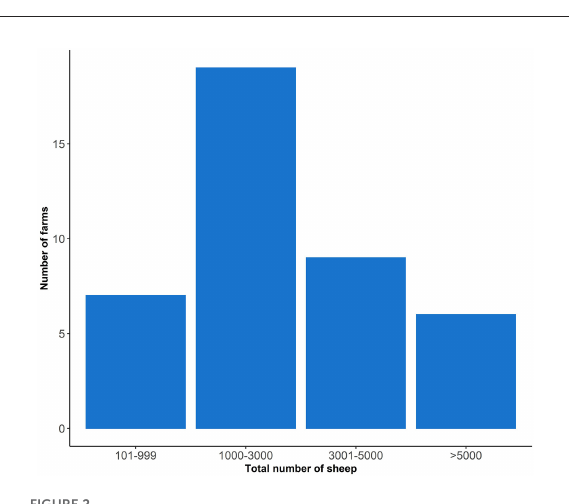
FIGURE2 The total number of sheep owned by 41 farmers who participated in the study; two farmers did not report their flock